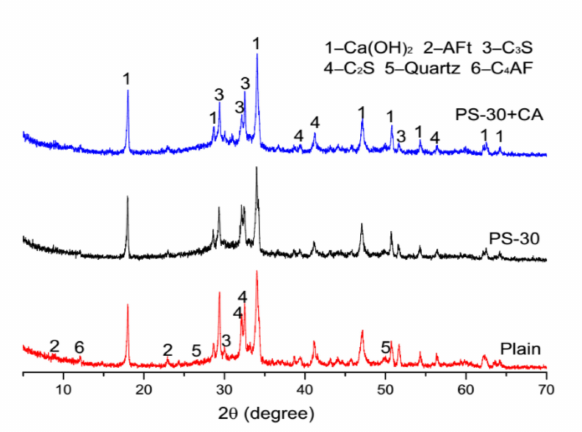
Figure 8. Hydration heat flow curves of plain pastes and cement pastes with 30% by mass of phosphorus slag and the chemical activator.